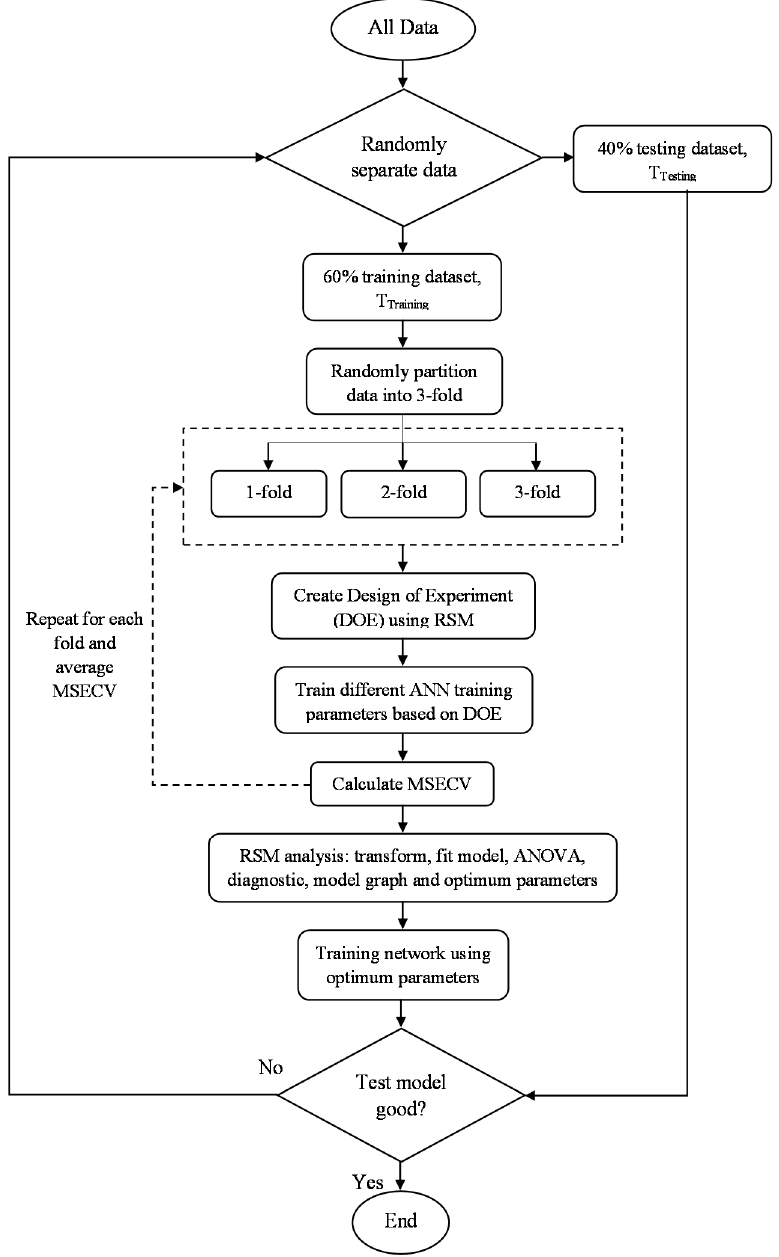
Figure 4. FFNN-RSM training parameters methodology.